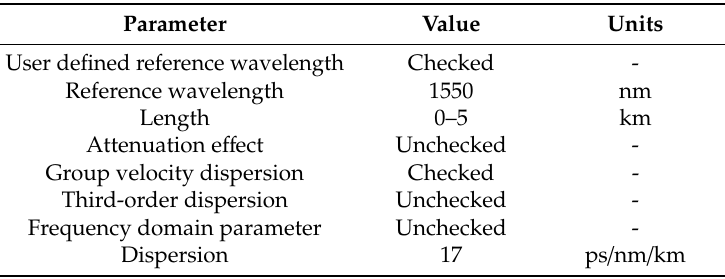
Table 6. Setting parameter of Optical